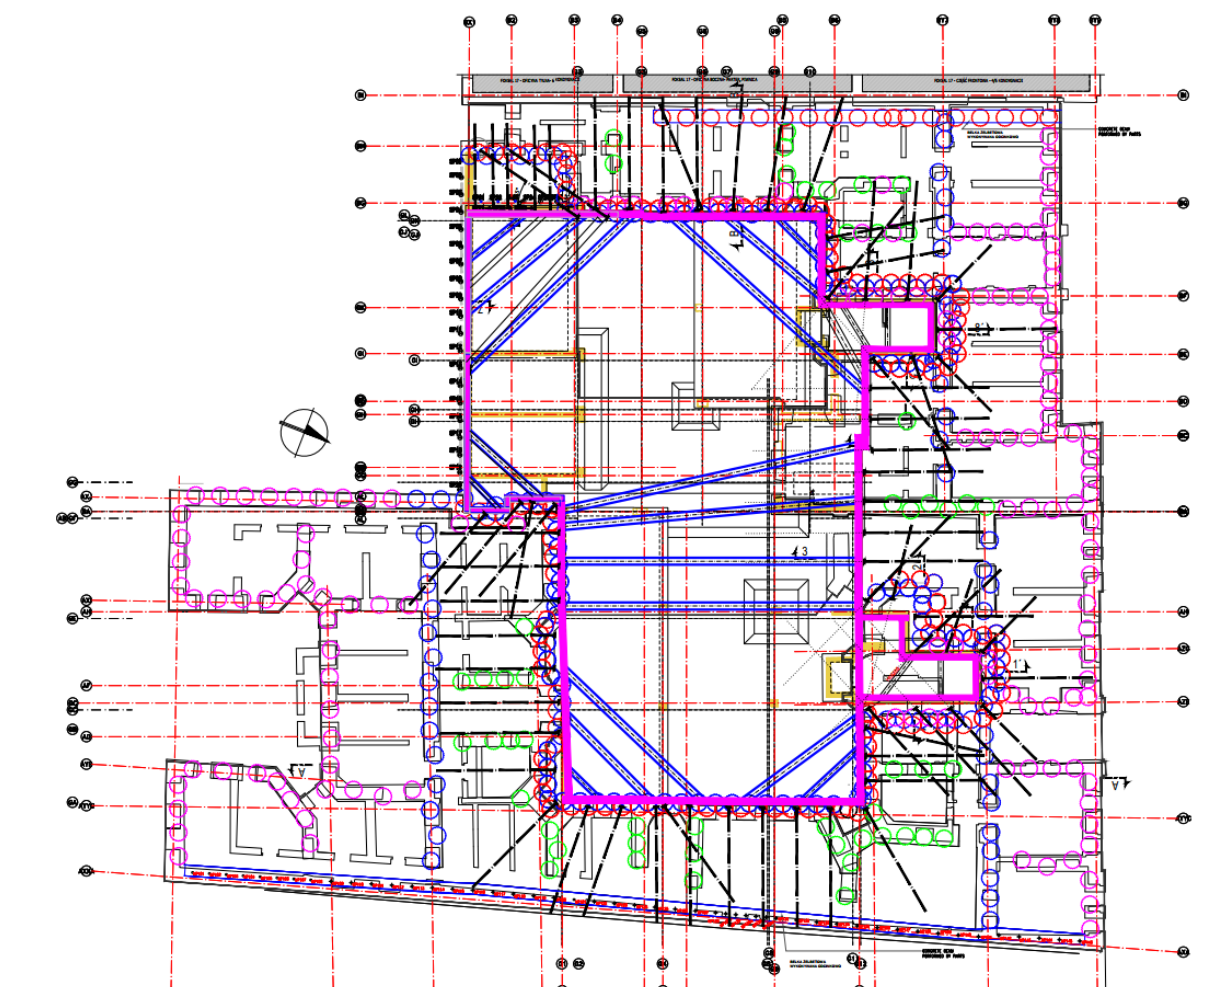
Figure 3. Layout – all the designed construction in one